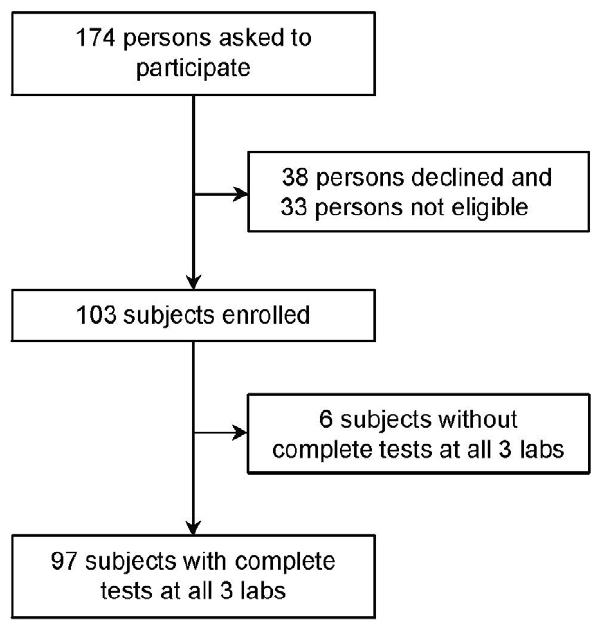
Figure 1. Study participation diagram.